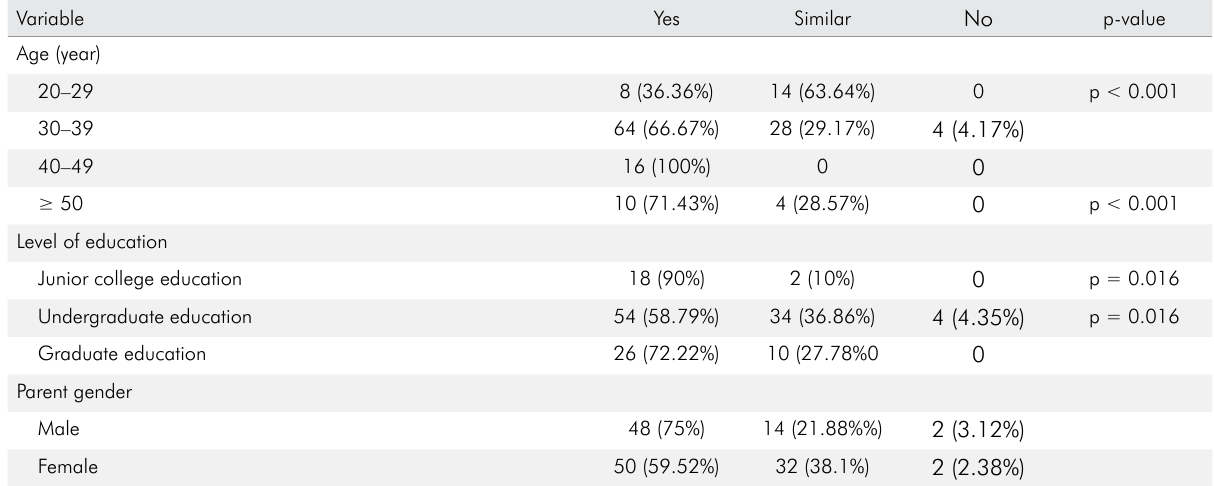
Table 3. Data on beliefs that the environment of the dental department was more dangerous than that of other public places (by parent age, level of education and gender)